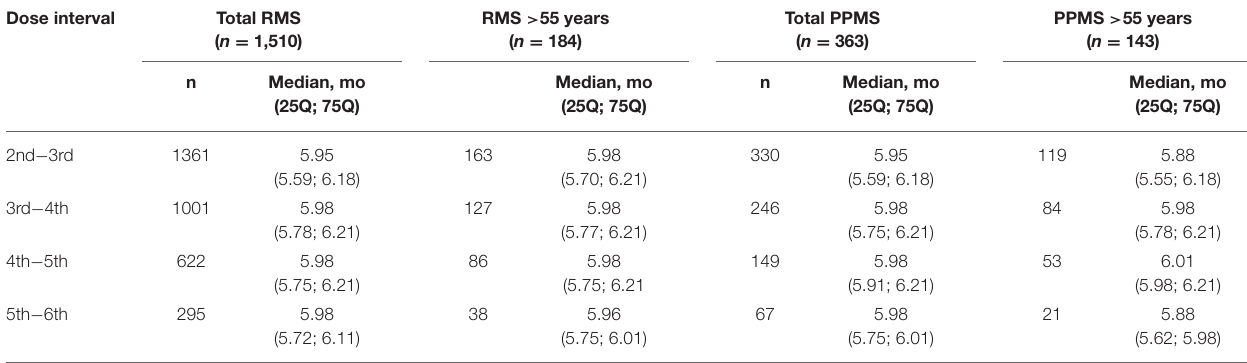
TABLE 4 | Median time interval between ocrelizumab dosing. Dose